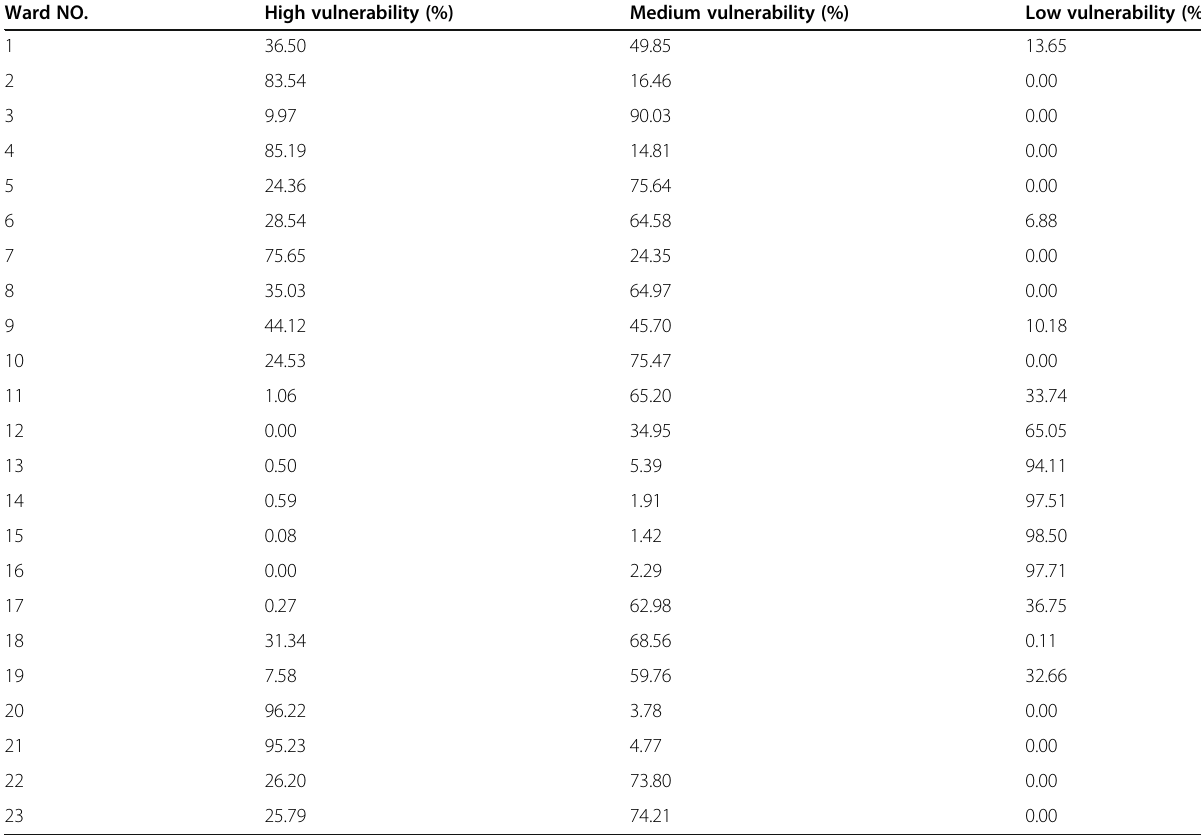
Table 4 Ward-wise distribution of PV to flood in Aluva municipality Ward NO.